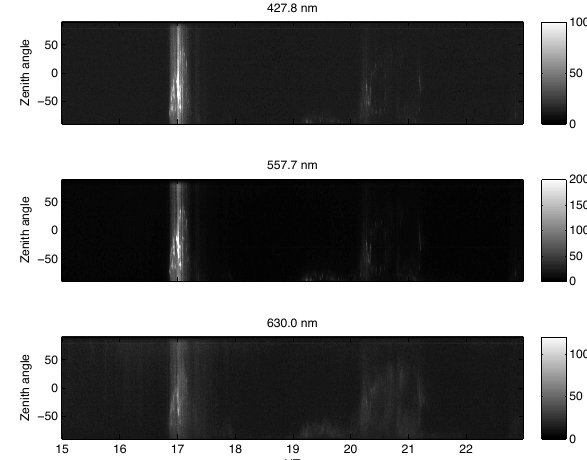
Fig. 8. ASC keograms from LYR station during substorm 2. Auro- ral emissions have been captured at the wavelengths of 427.8nm (top), 557.7nm (middle) and 630.0nm (bottom). The negative zenith angles are towards the south and positive towards the north (top of the panel).